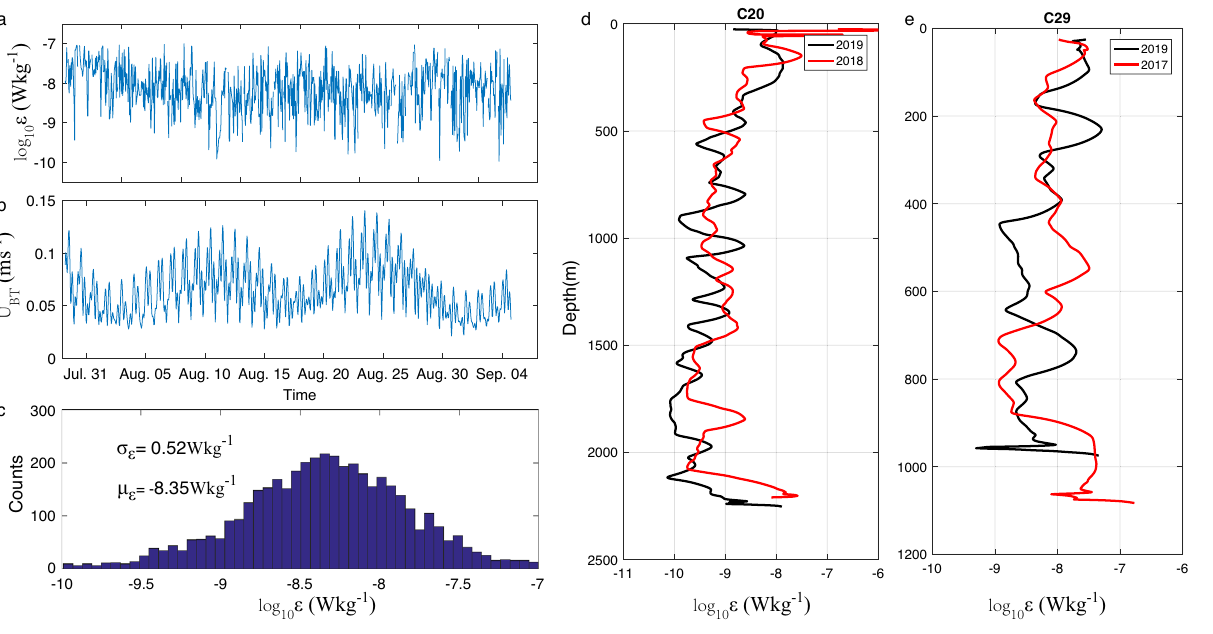
Figure 5. Panels ( a , b ) are the time series of the dissipation rates and the synchronous barotropic tidal current. Panel ( c ) shows the histogram of the fine-scale dissipation rate during the moored ADCP observation period. μ ε and σ ε are the mean value and standard deviation of the normal distribution of dissipation rates in log10 space. Panels ( c , d ) are repeated microstructure observations at C20 and C29 in different years.